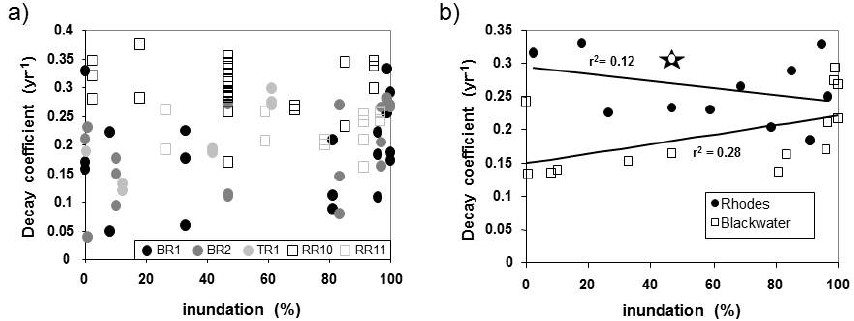
Fig. 3. Litter decay rate as a function of inundation duration. (a) Decay coefficients ( k ) of individual litter bags where markers refer to Blackwater River experiment 1, Blackwater River experiment 2, Transquaking River experiment 1, Rhode River experiment in 2010, and Rhode River experiment in 2011. (b) Decay coefficients ( k ) where replicate SOMbags at each elevation have been averaged together. For simplicity, Transquaking River data are not plotted. Star denotes the average decay rate for bags placed in the marsh adjacent to the Rhode River experiment.